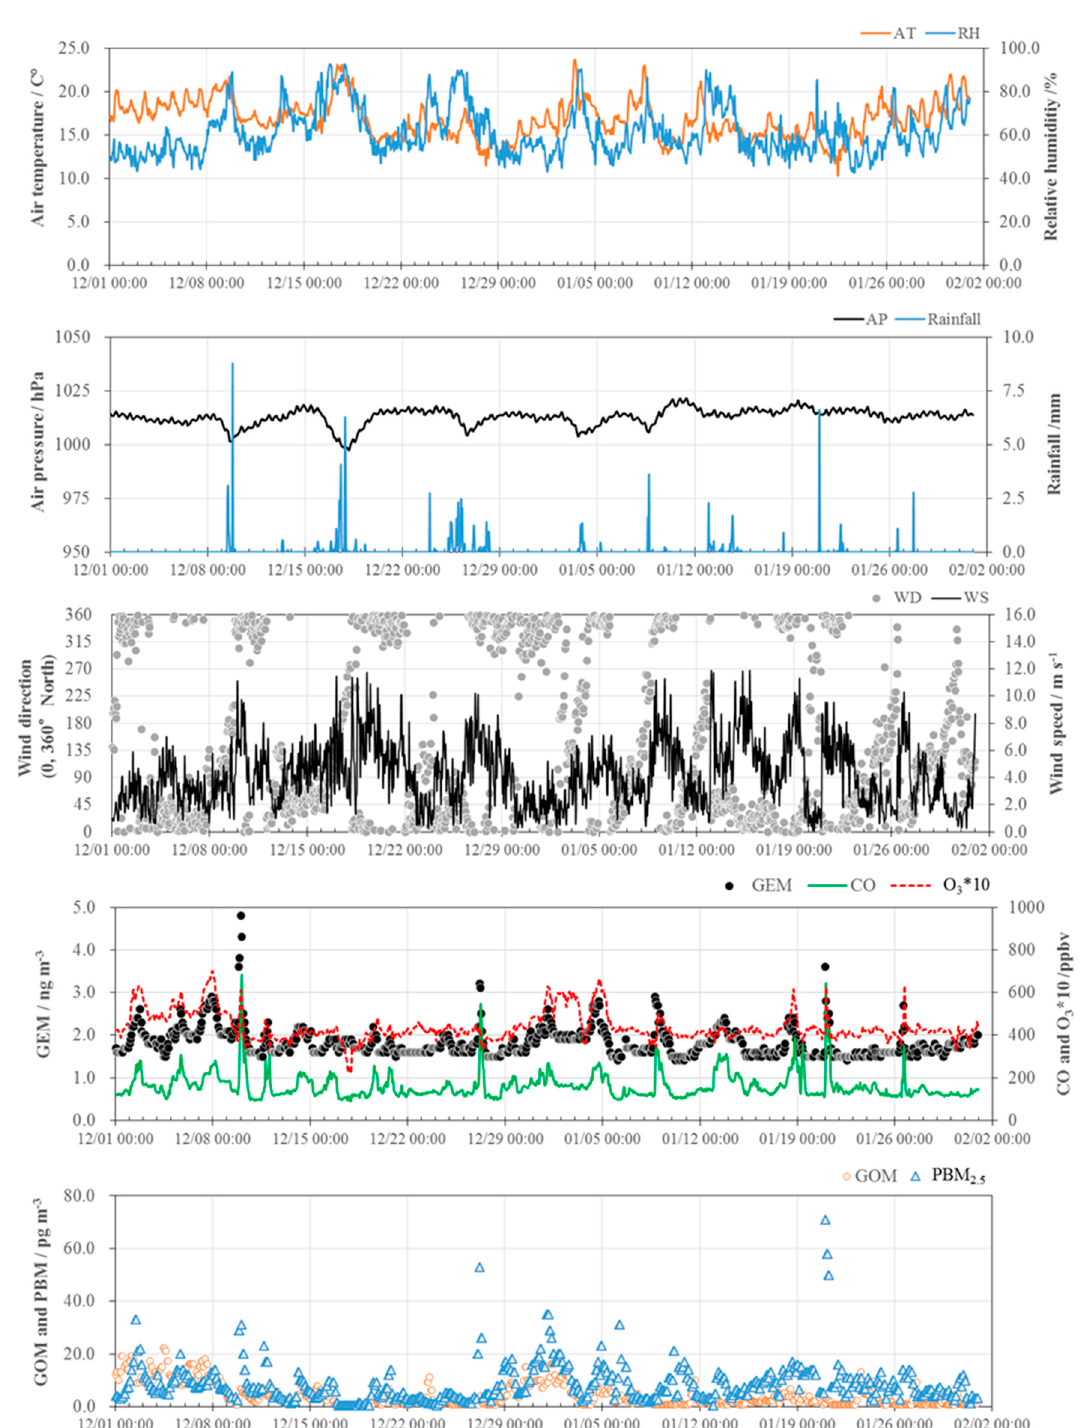
Figure 9. Typical examples of time series observed in the concentrations of GEM, GOM, PBM 2.5 , CO, and O 3 and meteorological parameters, including air temperature (AT), relative humidity (RH), air pressure (AP), rainfall, wind direction (WD) and wind speed (WS) during the period from December 2013 to January 2014.